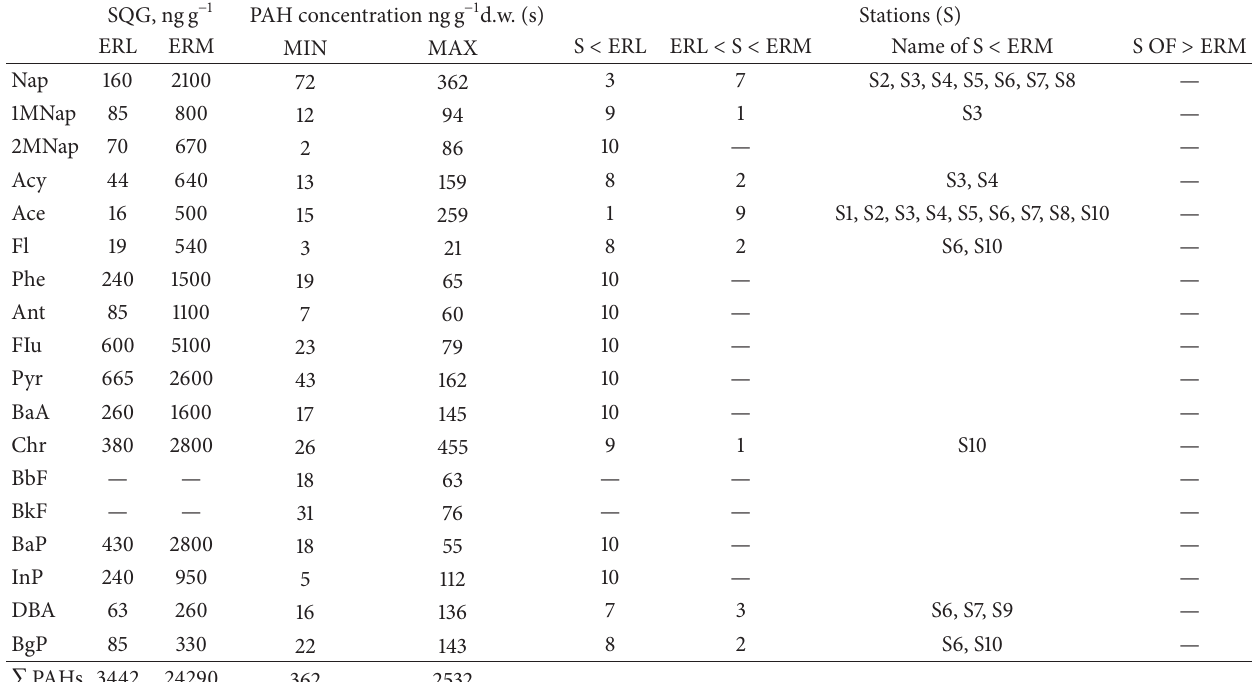
Table 9: Concentration ranges of PAHs in sediment from Langkawi Island and toxicity guidelines. SQG, ngg −